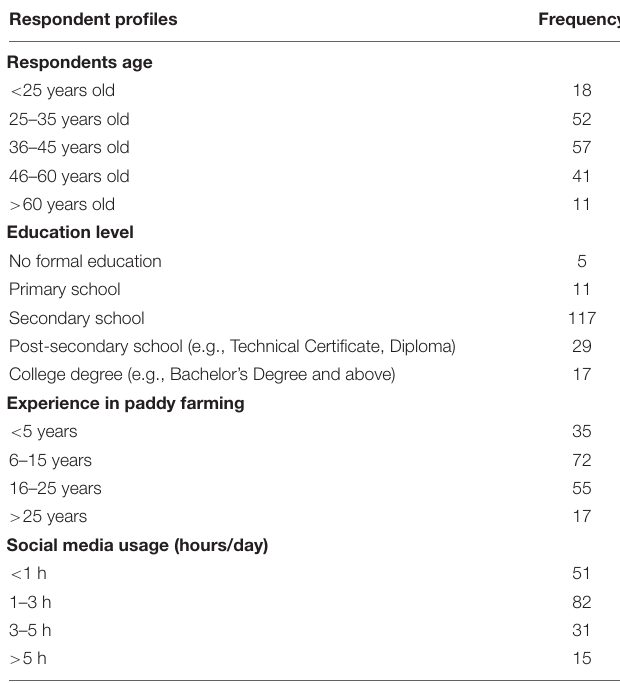
TABLE 3 | Respondents’ profiles and